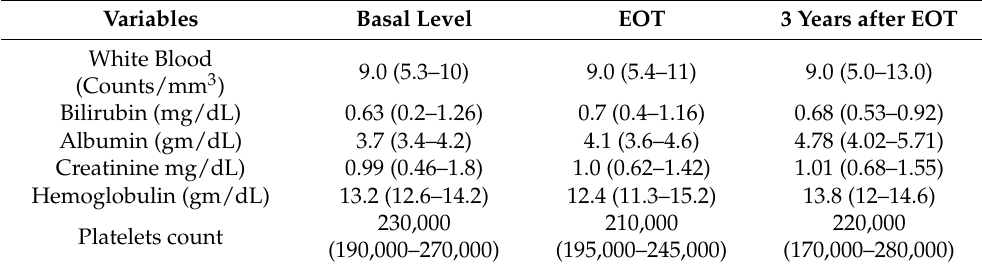
Table 2. Safety profiles of NASVAC in patients with chronic hepatitis B at different